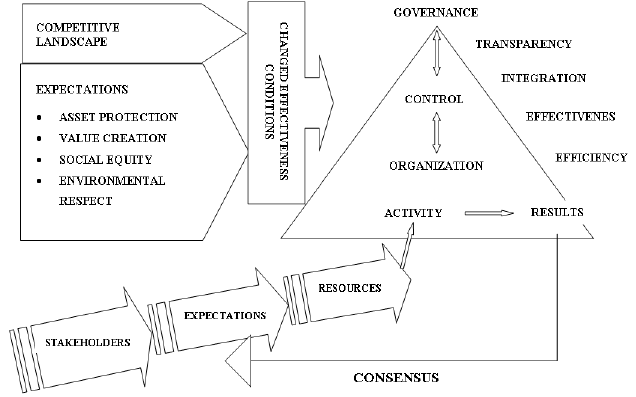
Figure 3: The Management Control Role in Corporate